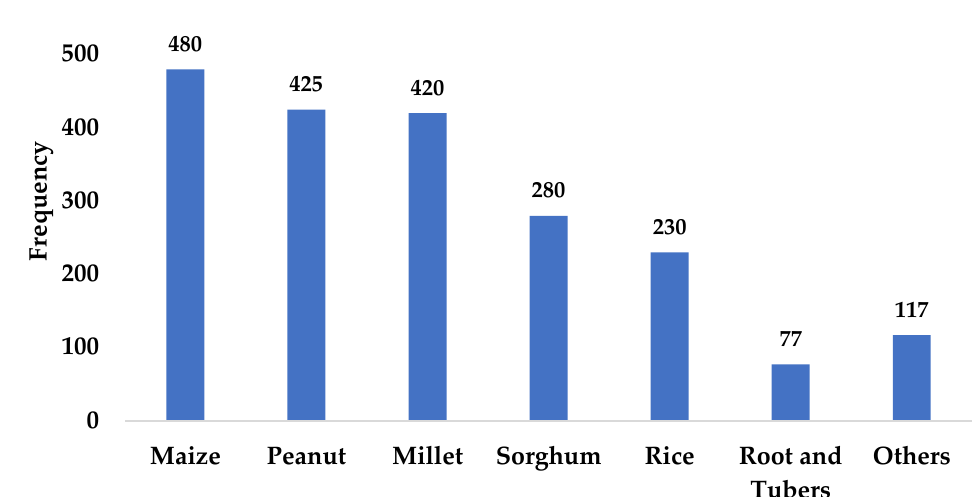
Figure 3. Main crops grown among survey respondents ( n = 866). Note: Other responses described the following “other” crops: okra ( n = 54), onion ( n = 49), tomatoes ( n = 48), chili ( n = 33), eggplant ( n = 29), cabbage ( n = 19), hibiscus ( n = 15), watermelon ( n = 15), sorrel ( n = 6), fonio ( n = 7), cassava ( n = 2), banana ( n = 2), and wheat ( n = 1).